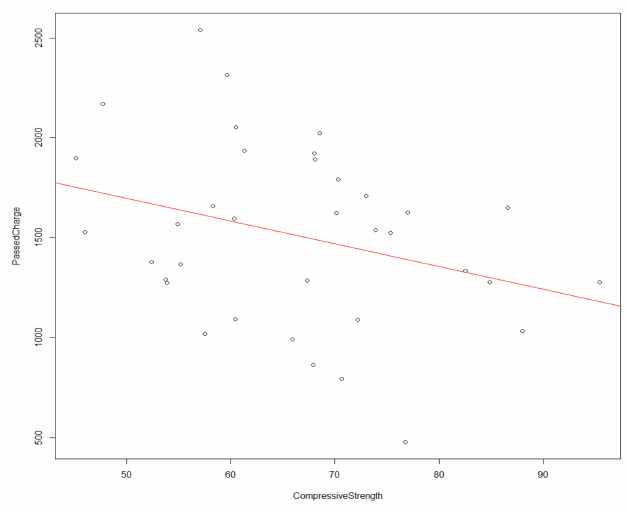
Figure A1. Simple linear regression of compressive strength and accumulated charge passed (small circles: data points (original scale); red line: Equation